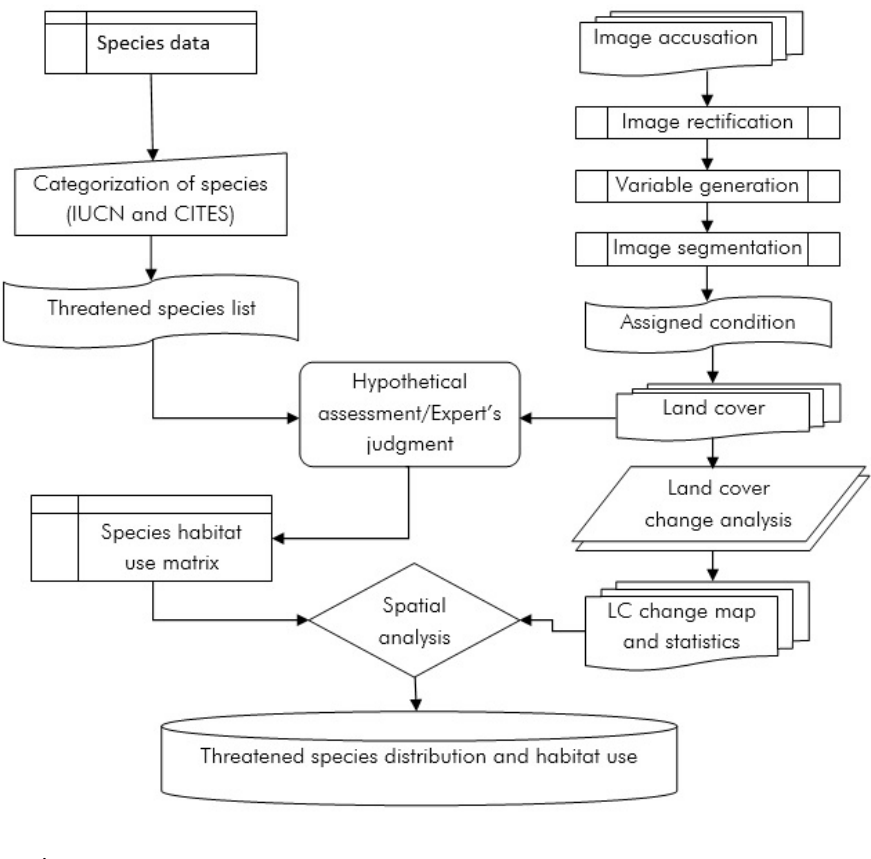
Figure 2. Flow diagram of study